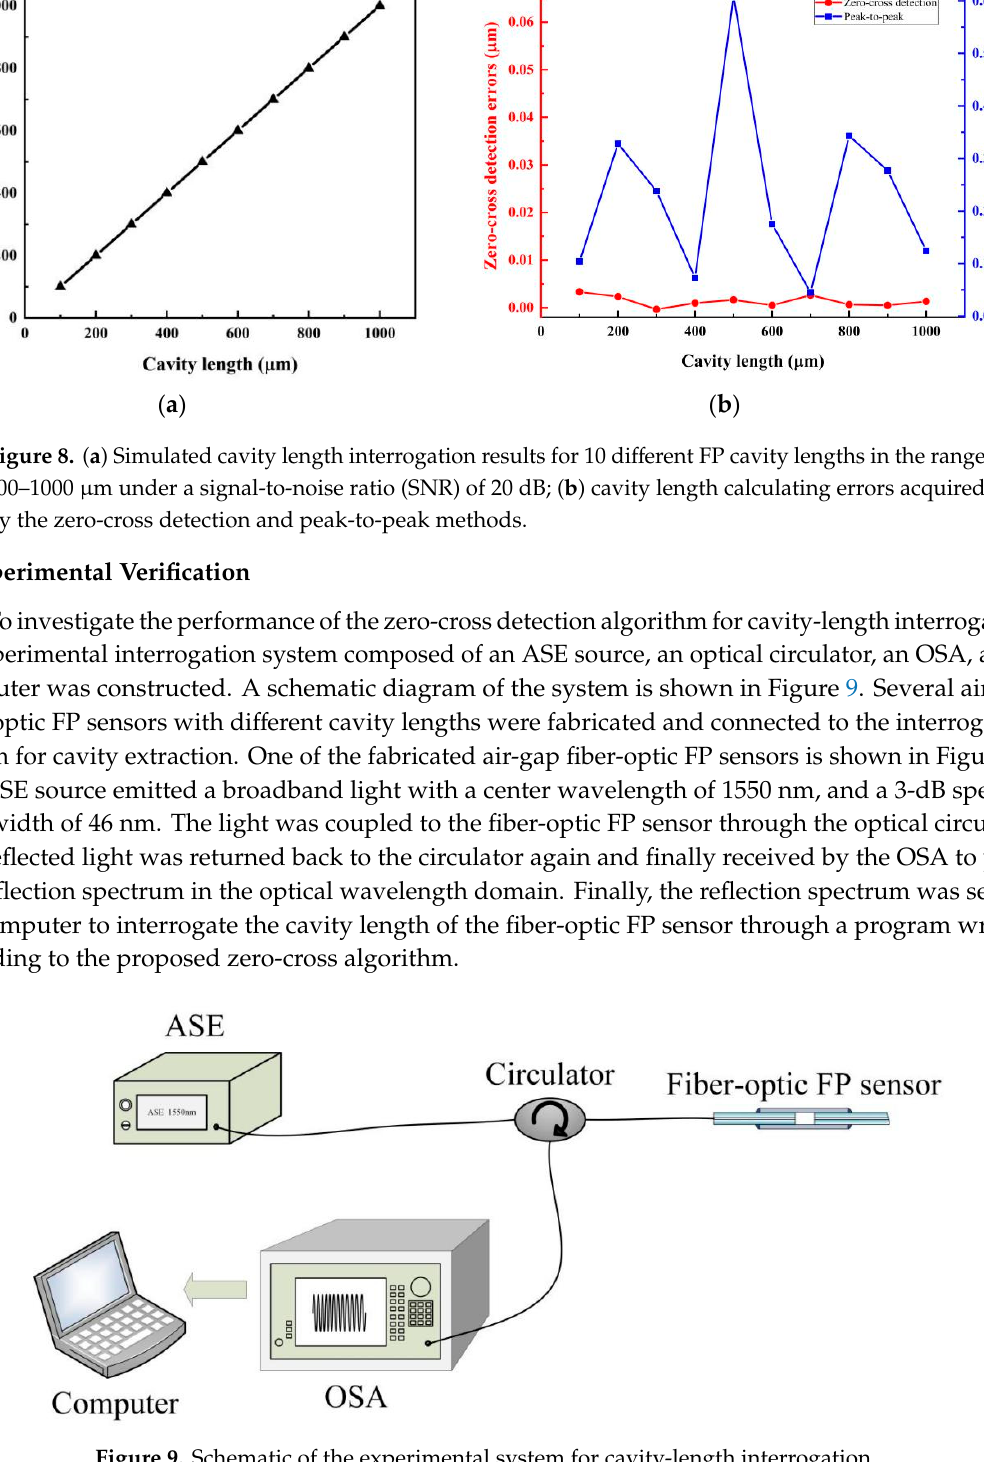
Figure 10. Microscopic photograph of an air-gap fiber-optic FP sensor to be interrogated. The reflection spectrum for a cavity length of 999.482 μ m is shown in Figure 11, which has multiple peaks in the spectrum. Figure 11. The reflection spectrum in the optical frequency domain of a fiber-optic FP sensor with a cavity length of 999.482 μ m.